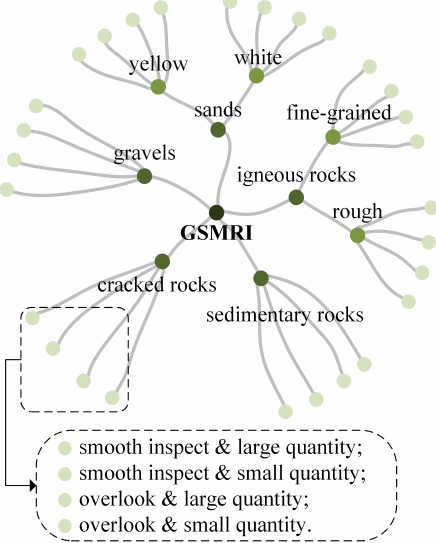
Figure 1. The hierarchy of GMSRI. GMSRI is a four-level tree structure, the second level corresponds to five rock categories, the third level contacts subdivide some rock categories, and the fourth level nodes classify rocks from view angle and quantity of rocks.